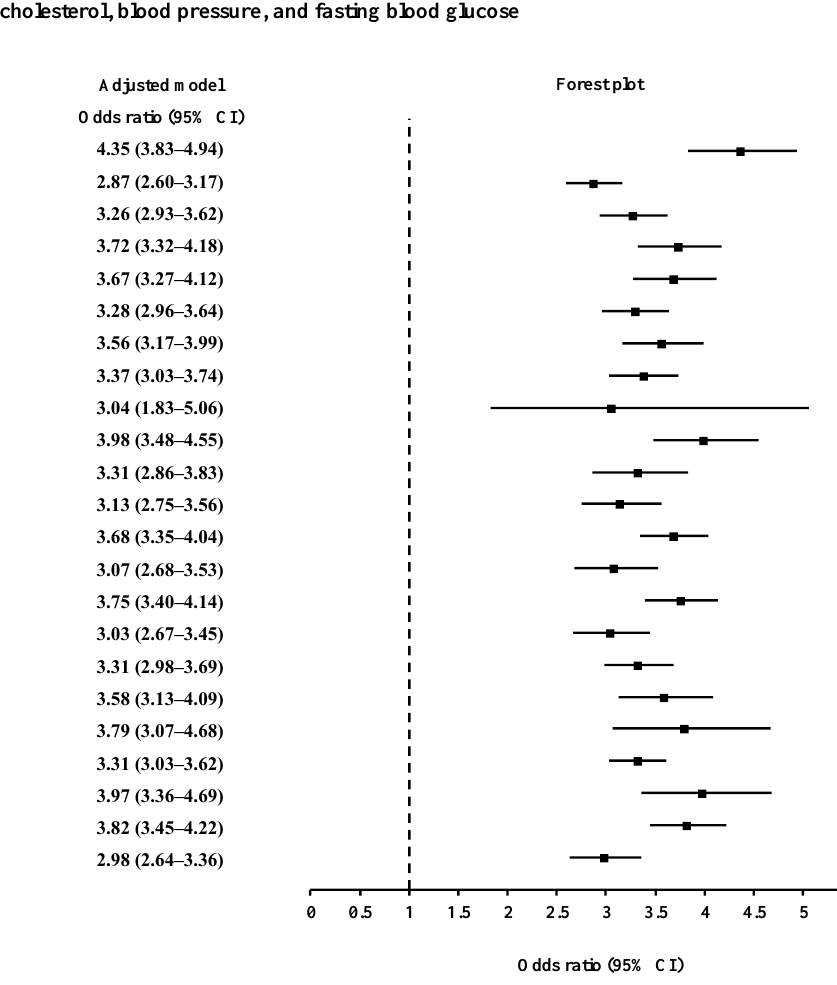
Figure 3. Subgroup analyses of PPI prescription dates ≥ 365 for BPPV according to age, sex, income, region of residence, obesity, smoking status, alcohol consumption, total cholesterol, blood pressure, and fasting blood glucose visualized with forest plot. Abbreviations: BPPV, benign paroxysmal positional vertigo; DBP, diastolic blood pressure; PPI, proton pump inhibitor; SBP, systolic blood pressure.